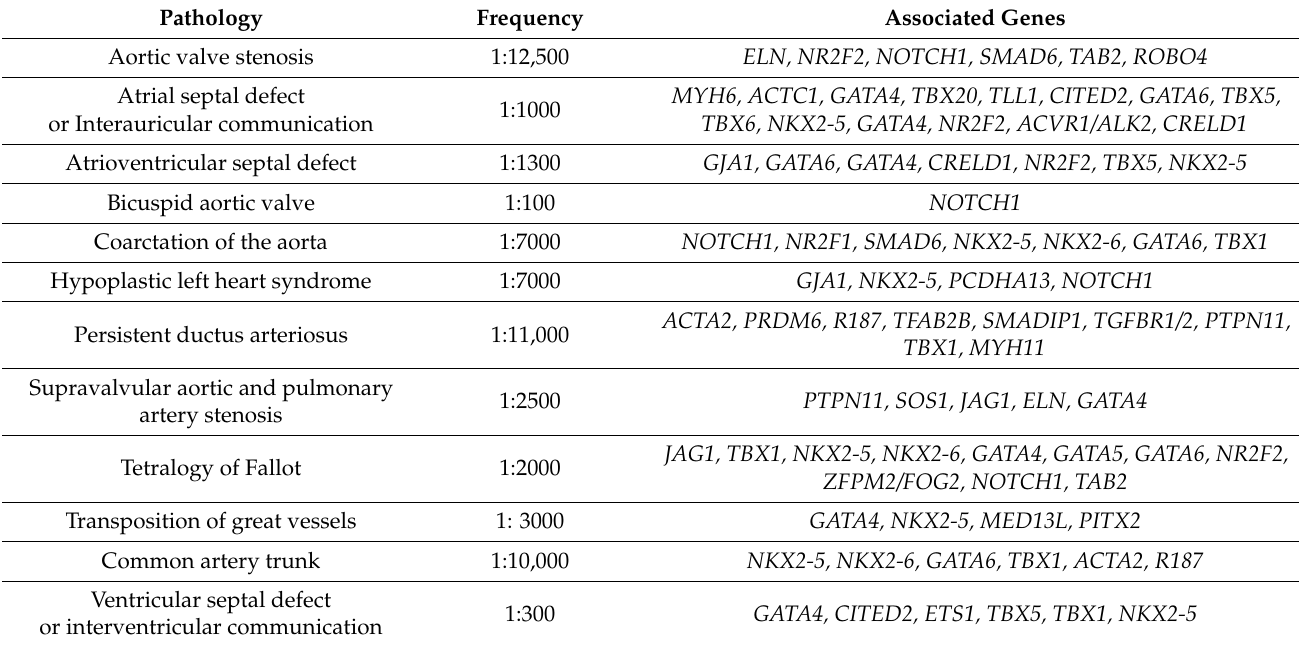
Table 1. Main congenital heart